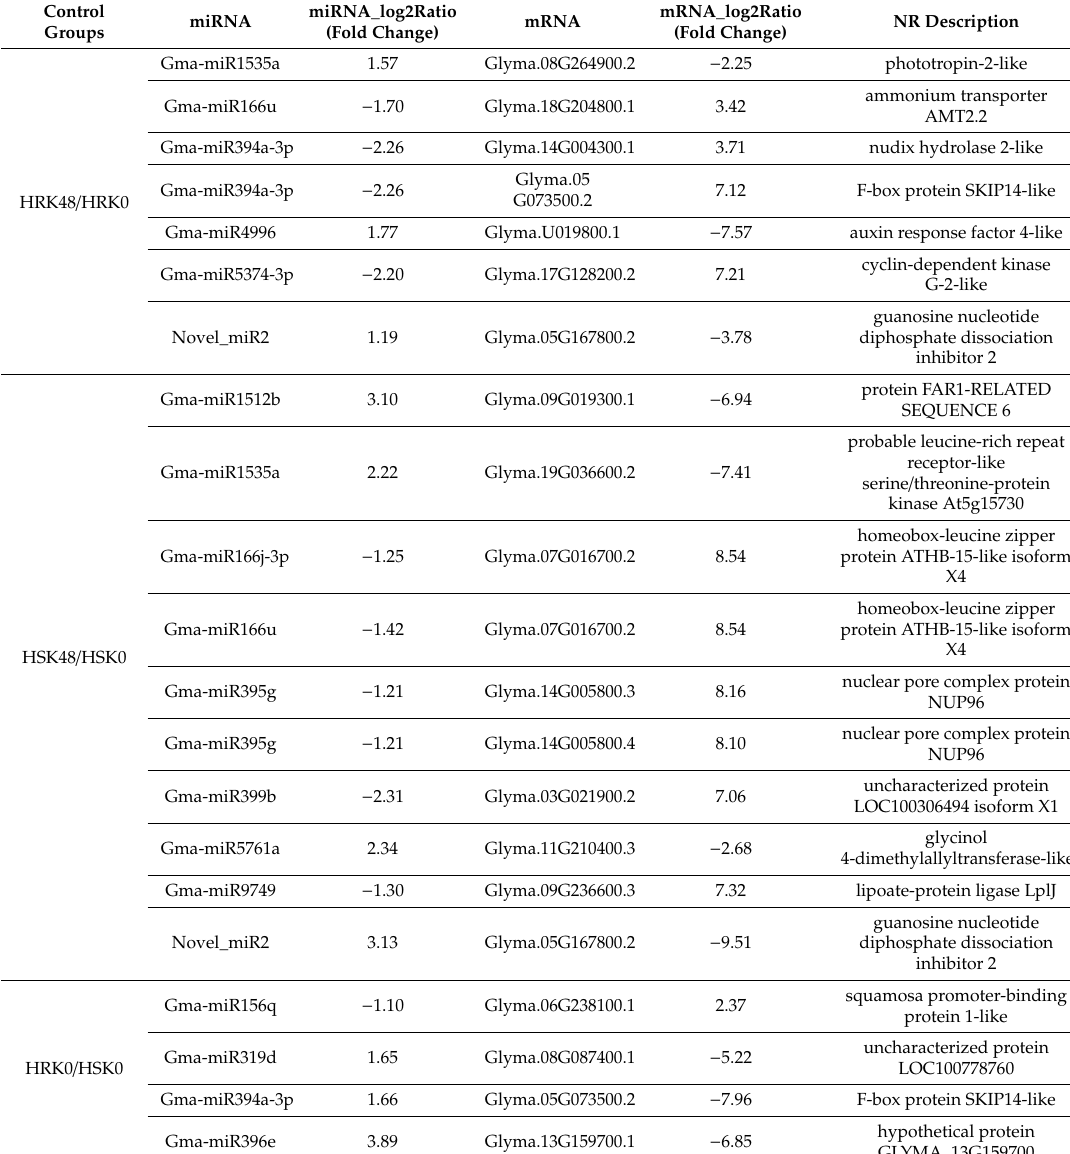
Table 3. Correlation analysis of di ff erentially expressed miRNA and negative regulation of di ff erentially expressed